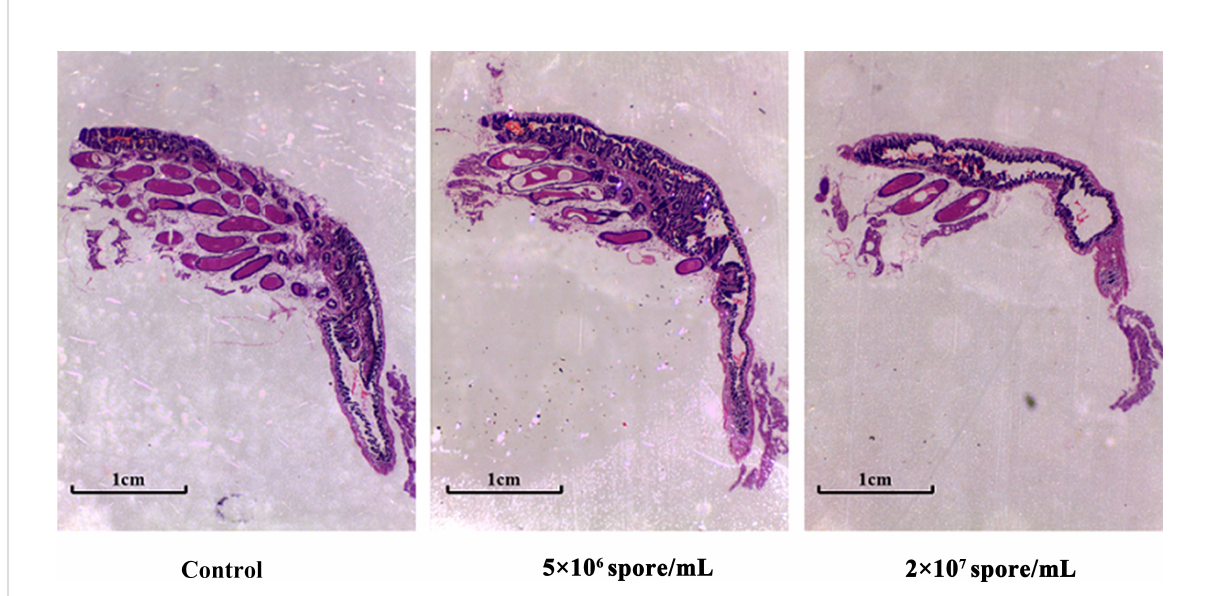
FIGURE 4 Effects of different spore concentrations of P. locustae on ovary development in L. migratoria manilensis . Longitudinal sections of locust ovarian tissue on day 8 after eclosion. Ovarian tissues were fi xed with formaldehyde solution and then dehydrated in an ethanol series. After clearing with xylene, the samples were embedded in paraf fi n and stained with hematoxylin and eosin (H&E). Samples were observed and photographed under amicroscope. Scale bar = 50 m m.